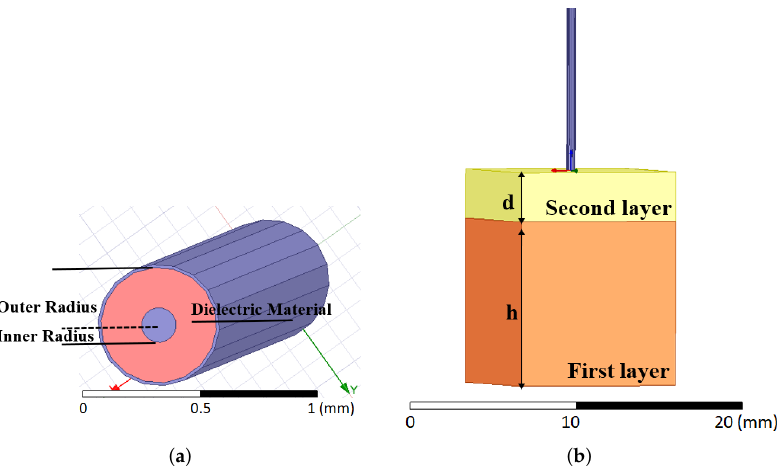
Figure 1. Simulated open-ended coaxial probe and configuration of double-layered sample. ( a ) Open- ended coaxial probe. ( b ) Double-layered sample, with the first layer being skin tissue with d 1 thickness and the second layer being olive oil with d 2